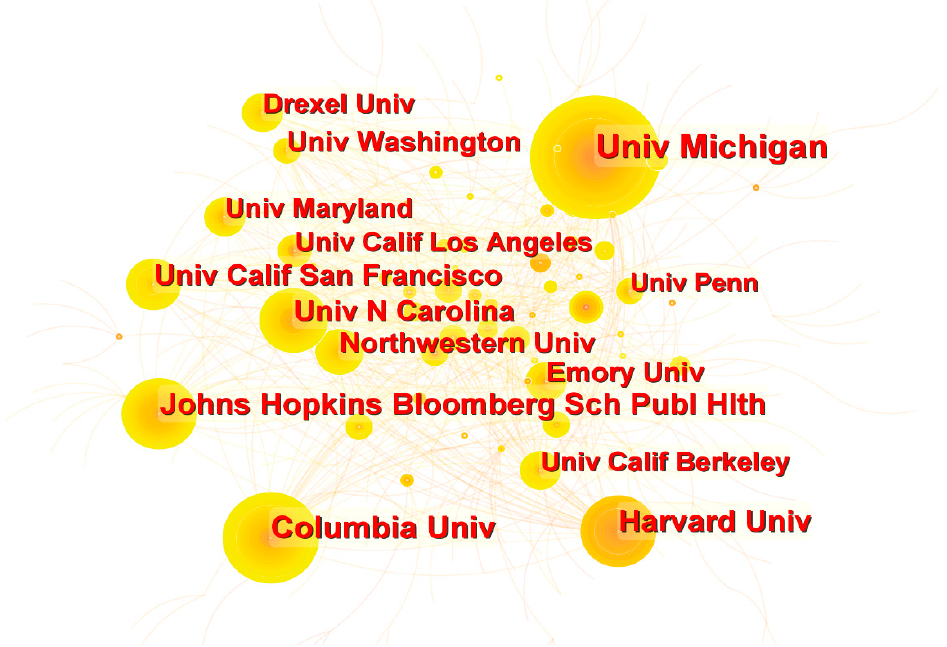
Figure 3. A network map showing institutional collaborations in RSH research. Table 3. Top 10 research institutions in the field of RSH.